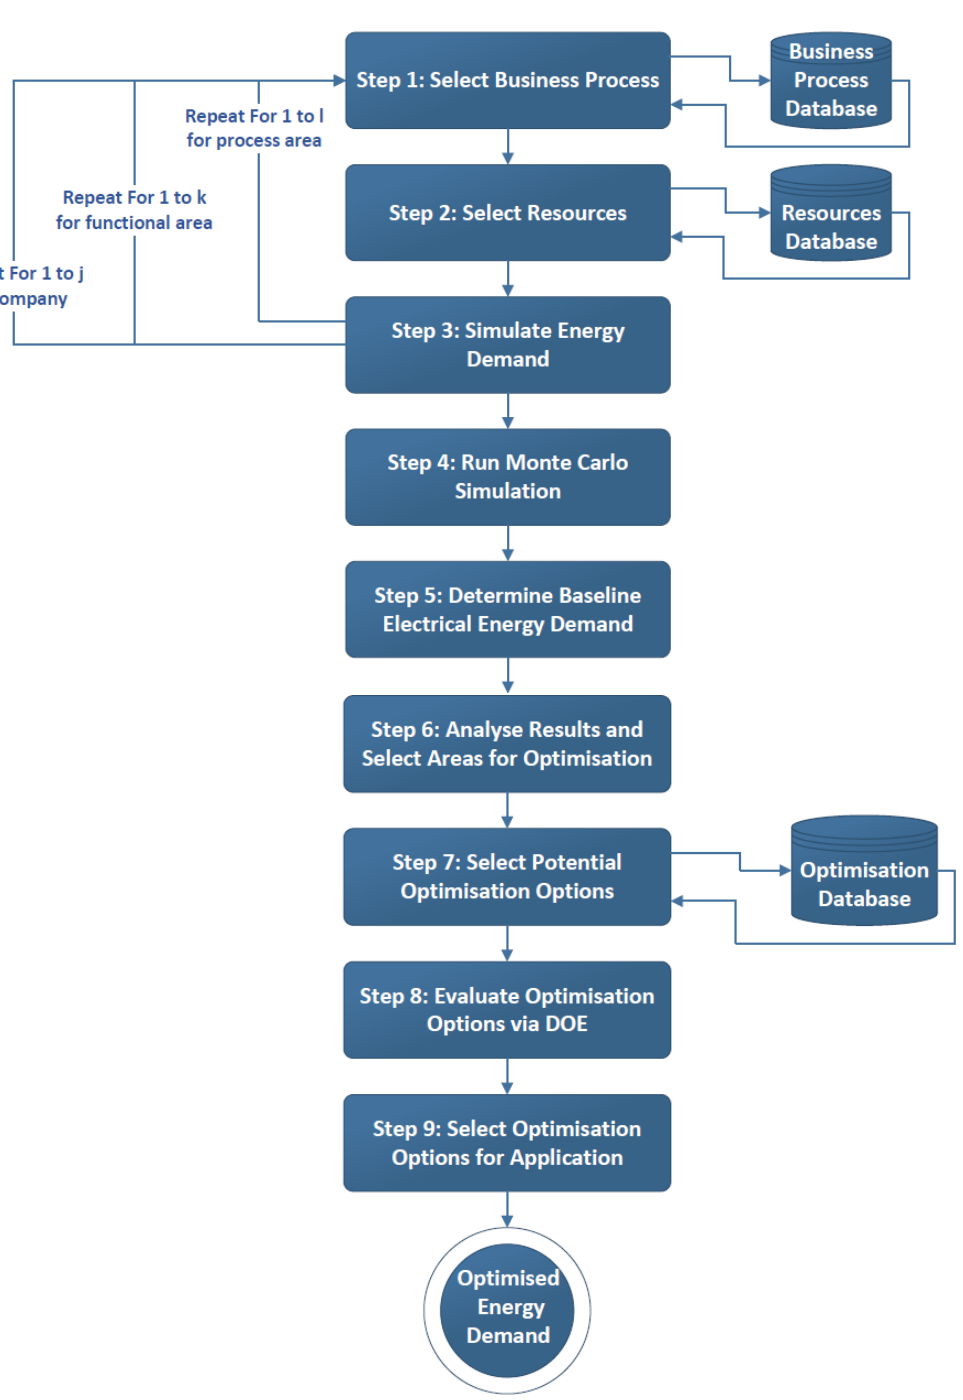
Figure 2. Energy modeling